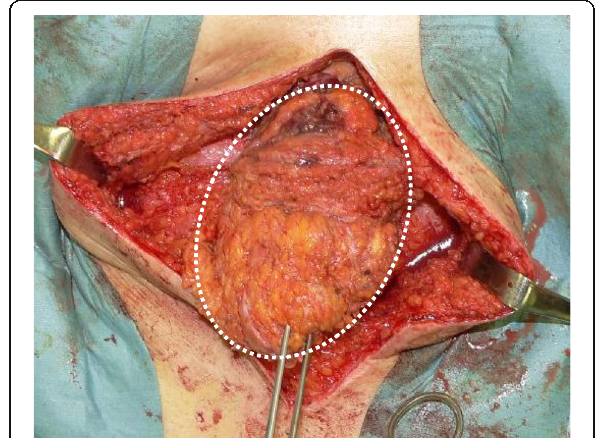
Fig. 3 Complete removal of the abscess wall (dashed circle) without damaging the peritoneum and abscess wall was